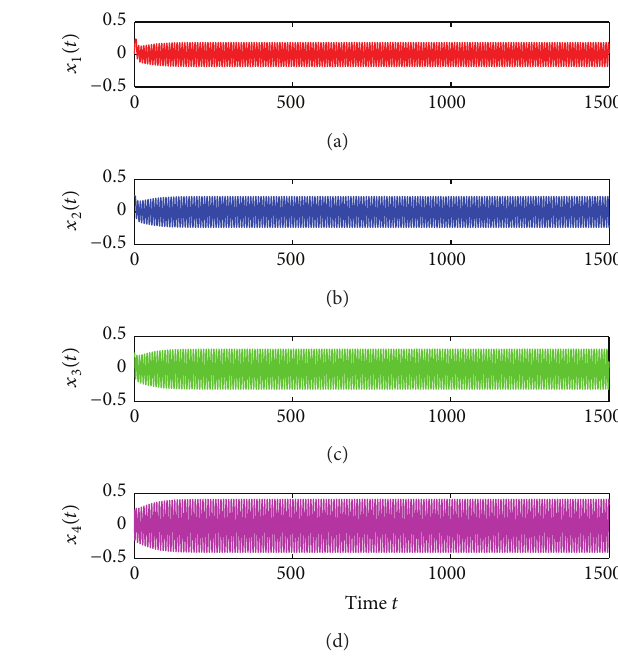
Figure 1: The trajectory of 𝑥 1 , 𝑥 2 , 𝑥 3 , and 𝑥 4 when 𝜏 1 = 1.3 < 1.4022 = 𝜏 10 .